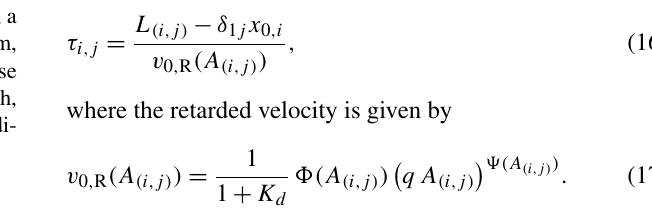
L i,j . Along this path, j = 1